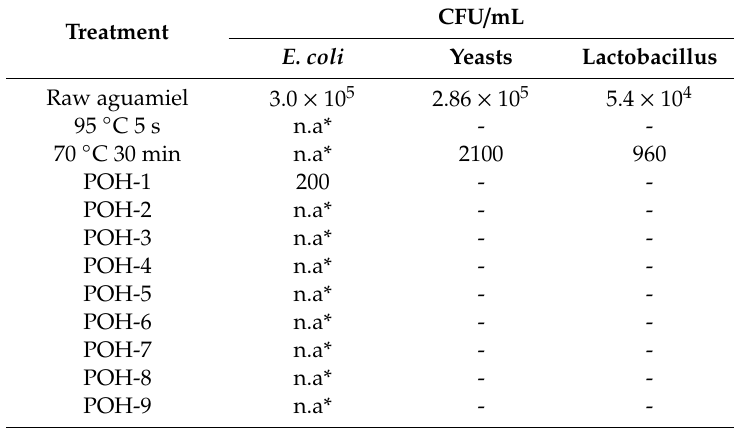
Table 2. Microbiological analysis of raw and pasteurized aguamiel by conventional and ohmic heating.